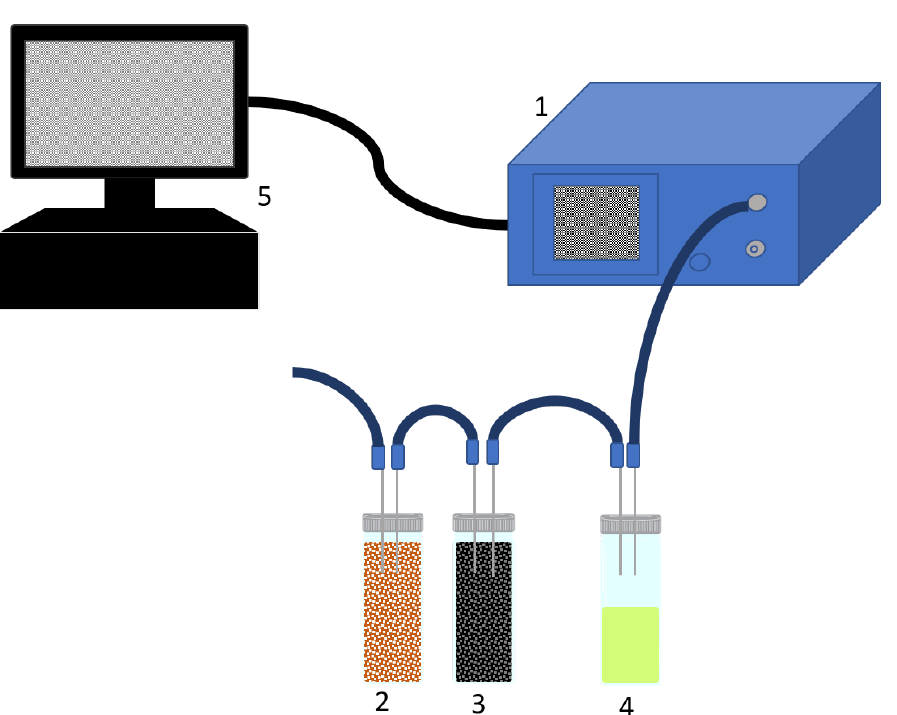
Figure 1. Schematic representation of the experimental setup of the electronic nose used in sample measurements (1 = PEN3 e-nose; 2 = silica gel filter; 3 = activated carbon filter; 4 = tested sample; 5 =